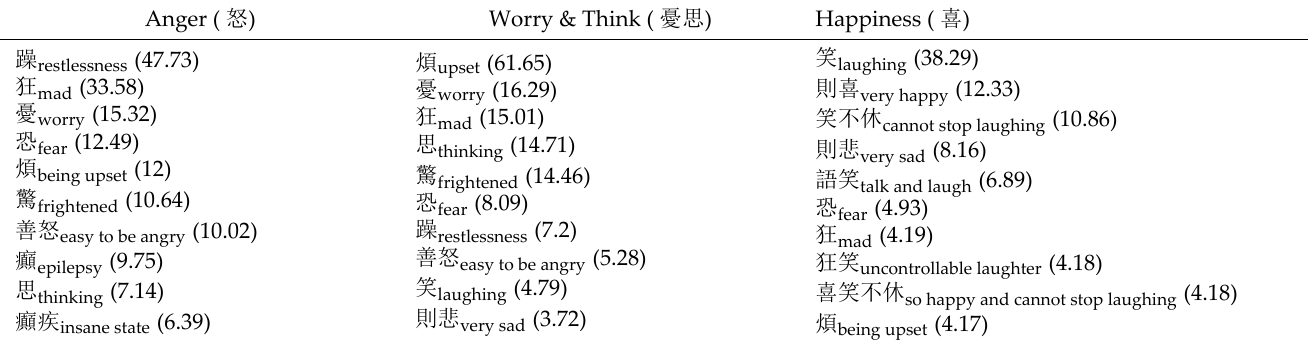
Table 1. Characteristics of the relationships between mental disorder categories and the top 10 men‑ tal disorder